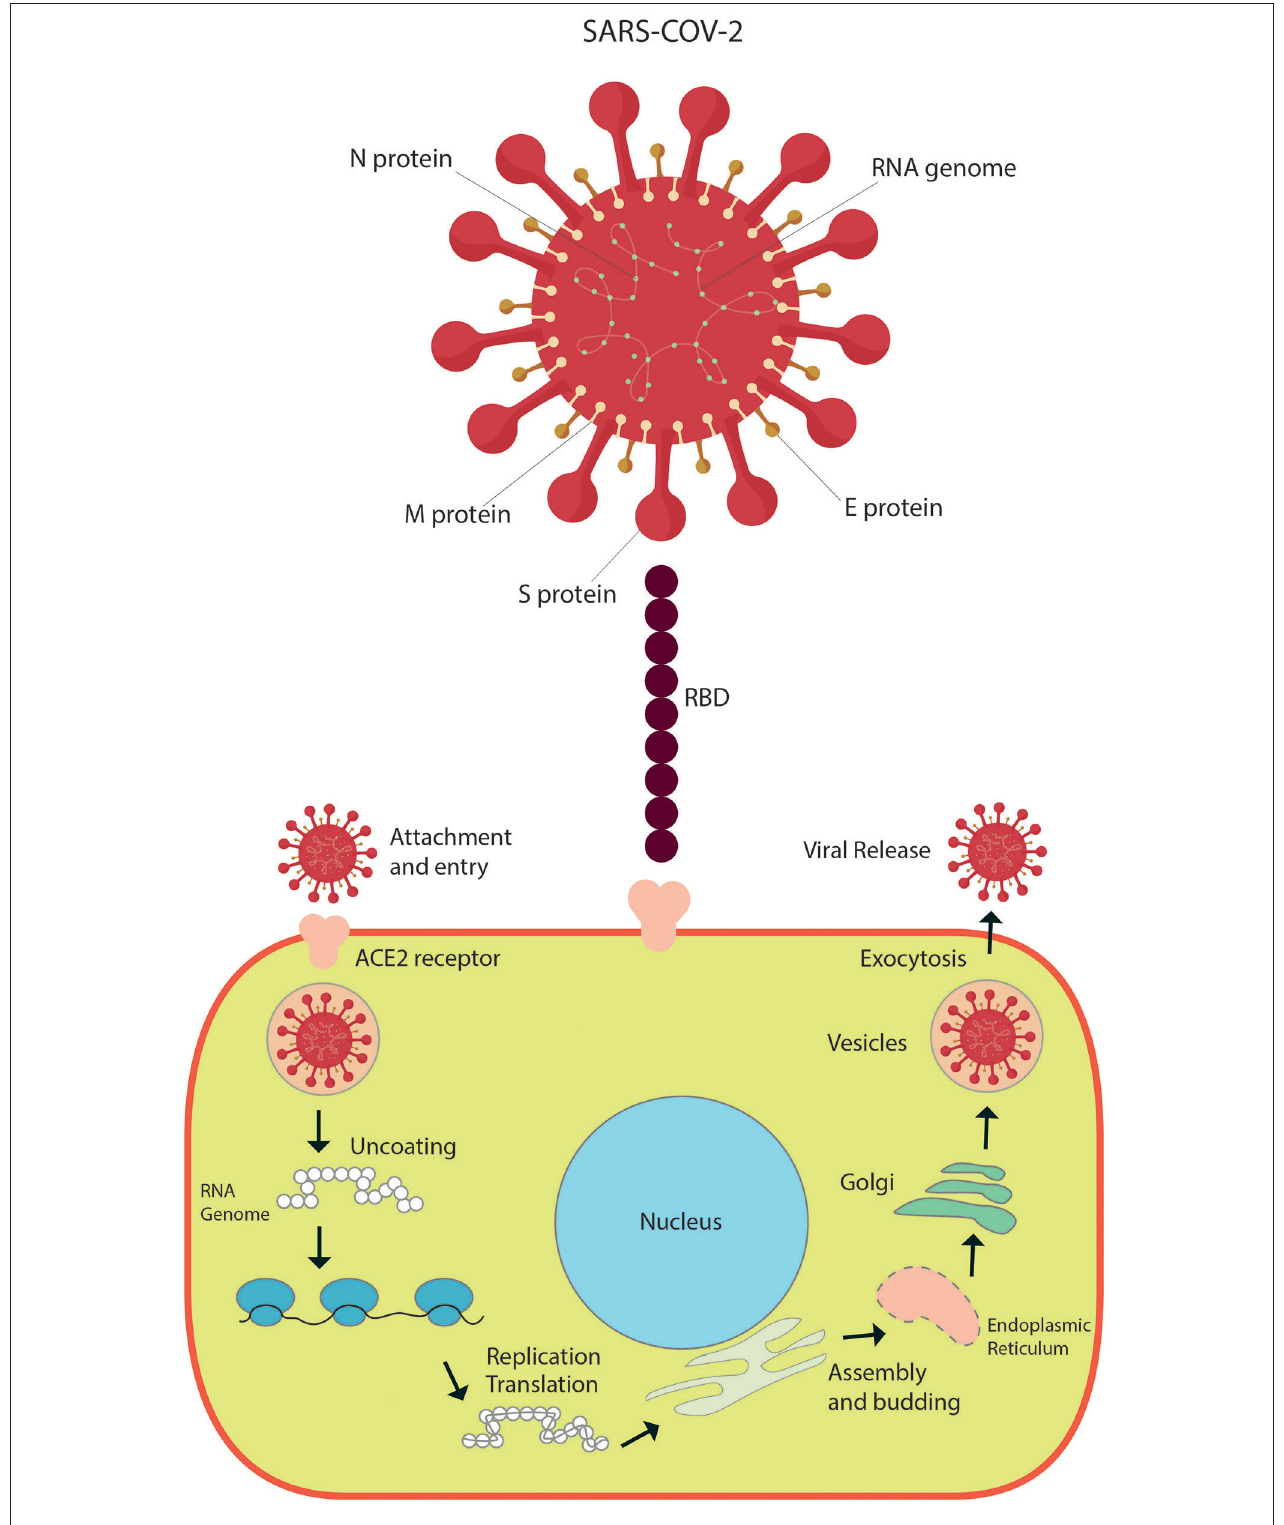
FIGURE 1 | Basic structure of SARS-CoV-2 and pathophysiology of infection.